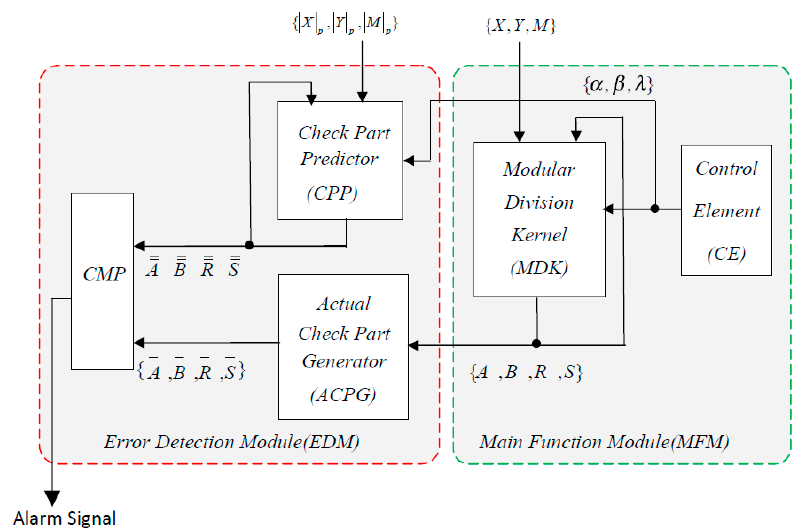
Figure 1. The concurrent error detection scheme for the modular division (MD) in [40].